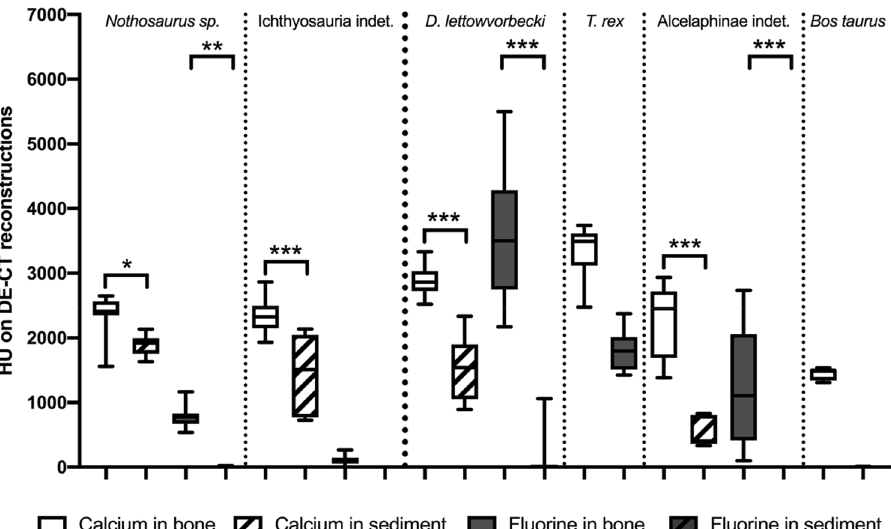
Figure 4. Nondestructive calcium and fluorine quantification in the bone and sediment using DECT. In the horizontal, the objects are divided into marine and terrestrial animals and listed in order of their geological time periods. Quantitative assessment of detected calcium and fluorine in DECT reconstructions in bone and sediment of the investigated specimen. DECT imaging revealed a difference in fluorine and calcium content in the Tyrannosaurus rex and Bos taurus specimens (p < 0.001). While the low fluorine content in the bone and sediment of the ichthyosaur was the exception, differences in calcium and fluorine in bone and sediment were significant in each sediment-embedded specimen. Significant differences between the bone and sediment are indicated by an asterisk (*p = 0.017; **p = 0.003; ***p <